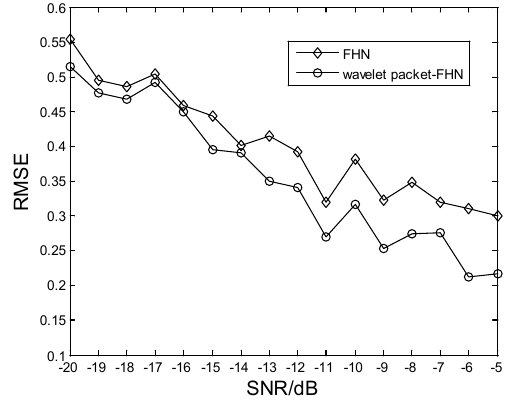
Fig. 6 Comparison of RMSE in two methods